Question: Condense the content of this figure into a single sentence.
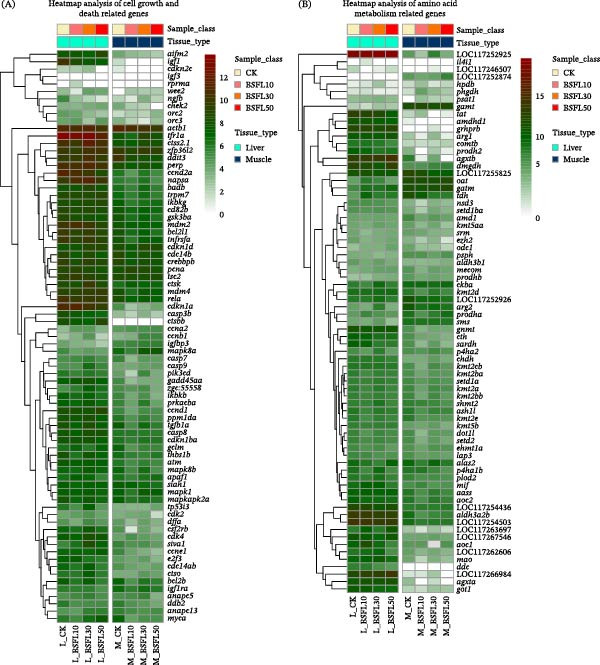
Answer: Differential expression analysis of genes related to (A) cell growth and death in muscle and liver; (B) amino acid metabolism in muscle and liver; and (C) lipid metabolism in muscle and liver.